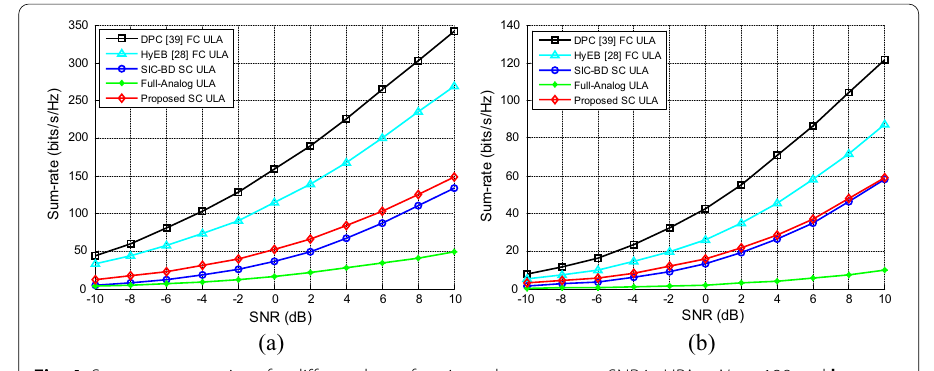
Fig. 4 Sum rate comparison for different beamforming schemes versus SNR in UPA. a N t = 128 and b N